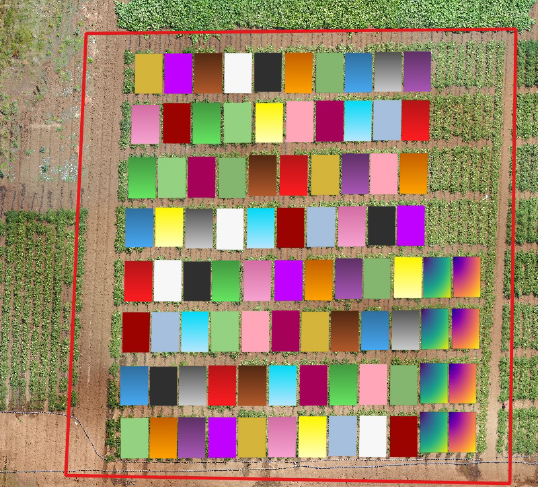
Figure 2. Experimental design that consider 22 varietals, and 4 repetitions, using a planting frame of 3 rows of 6 m, with an above and between rows of 0.25 m and 1.5 m, respectively, on a 0.4 ha farm.